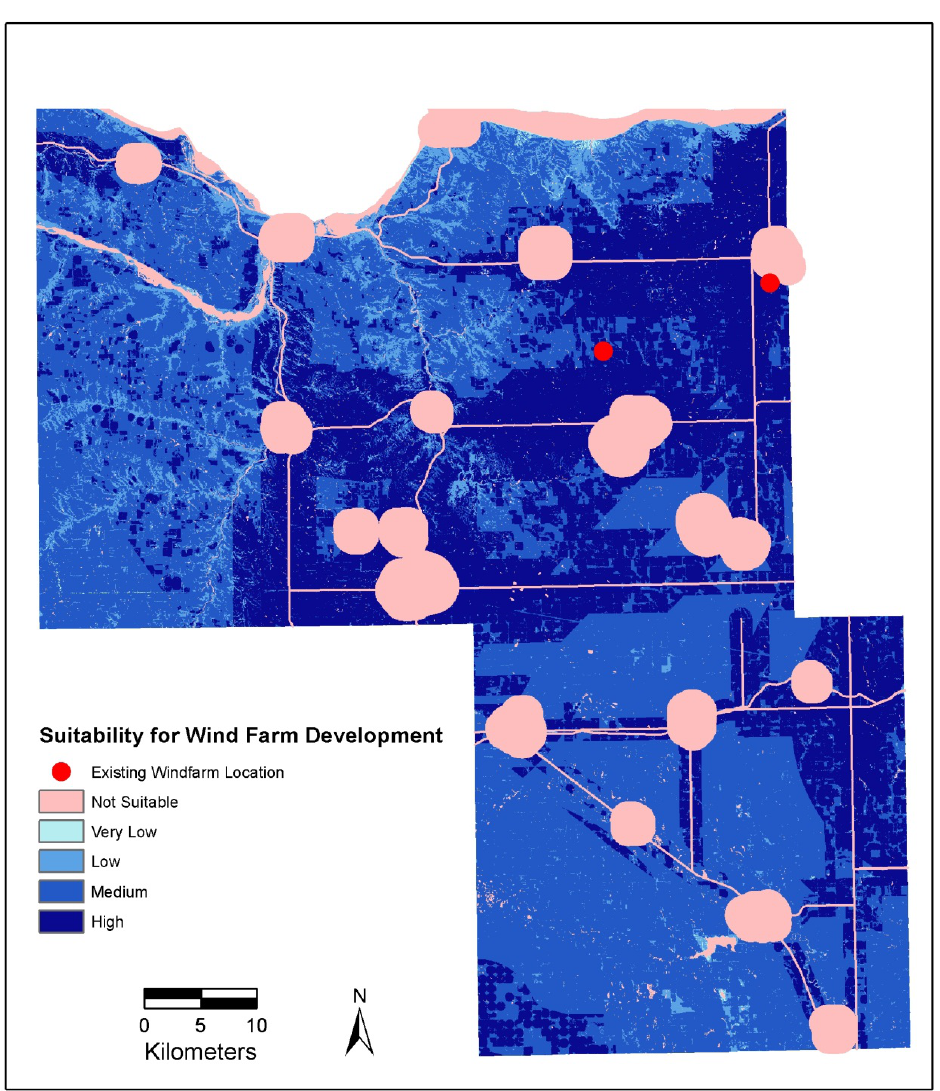
Figure 5. Suitability map for wind farm development in Northeast